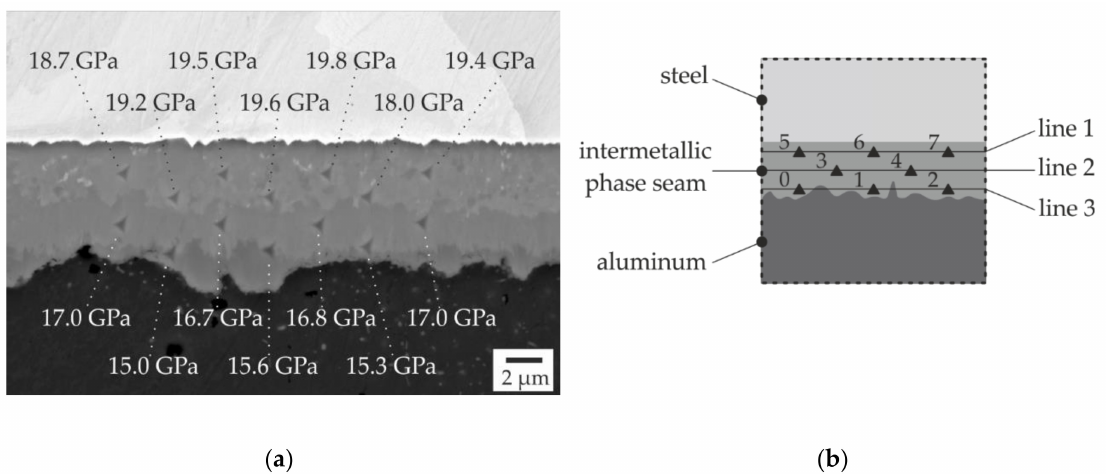
Figure 10. ( a ) SEM image and resulting nano hardness of a specimen, which was formed at a temperature of 590 ◦ C, a forming time of 480 s and a force of 5890 N, ( b ) Schematic representation of the approach used during the nano hardness measurements, see main text for